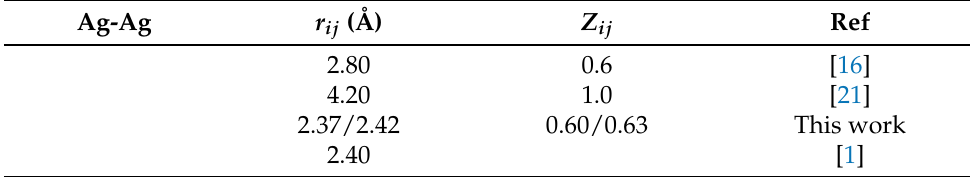
Table 2. Comparison of Ag-Ag PDF. The temperature at 300 K.